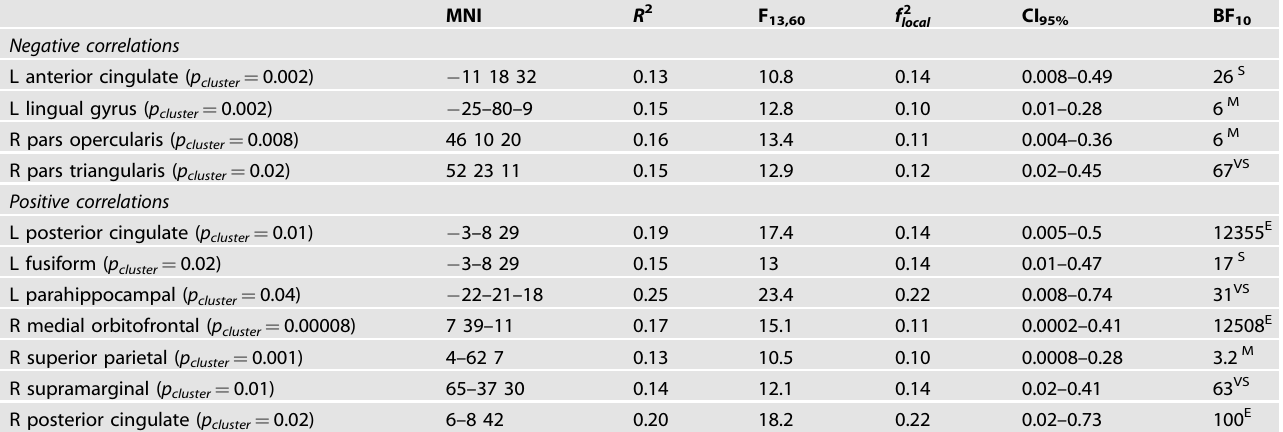
MNI coordinates are in MNI152 space. f 2 : measure of local effect size. CI 95% : 95% con fi dence interval. BF 10 : Bayes factor derived from Bayesian linear regression analyses. The superscript of the BF 10 indicates the qualitative interpretation of the evidence for the alternative hypothesis: M moderate; S strong; VS very